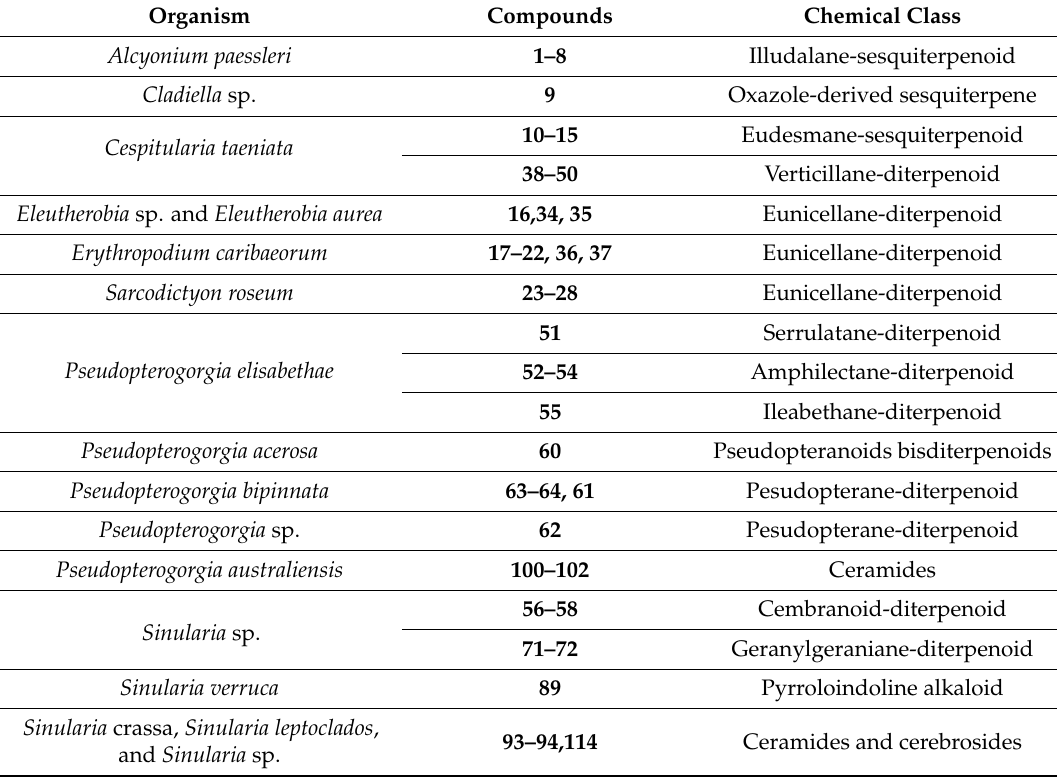
Table 2. Distribution of nitrogen-containing metabolites isolated from soft corals by skeletal